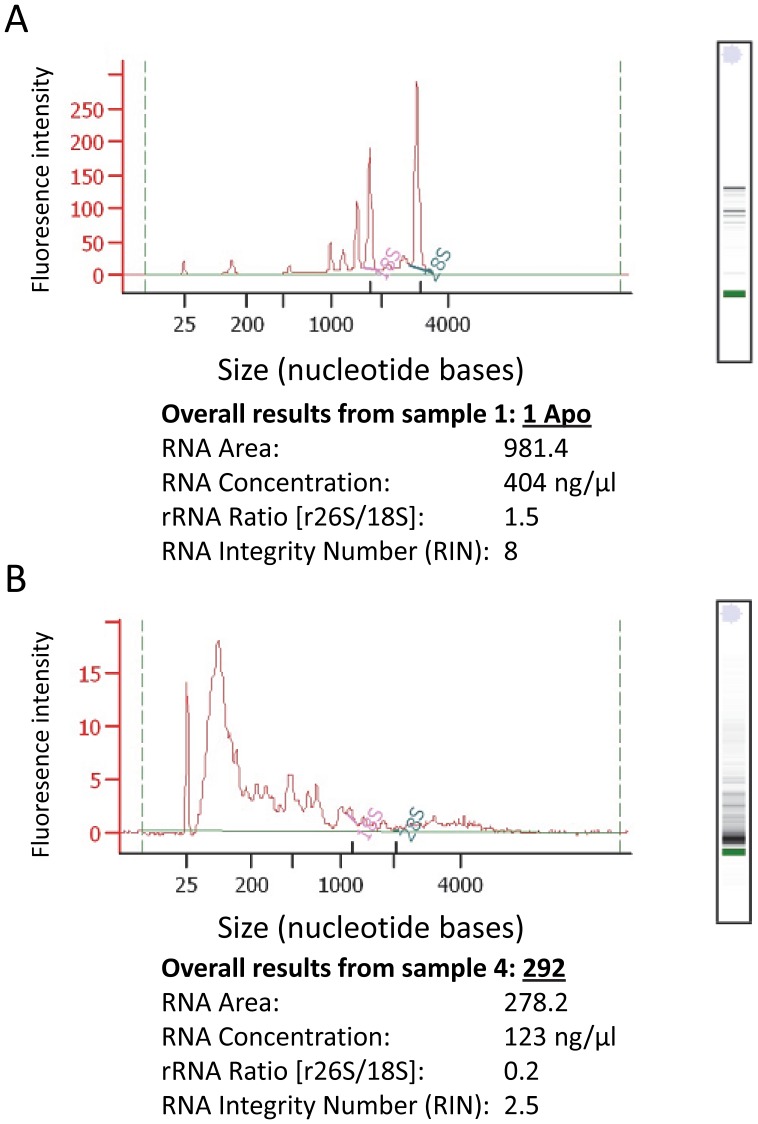
Example of the qualitative and quantitative results from Agilent’s Bioanalyzer 2100.In panels (A) and (B) we show peaks produced from electropherograms (top left) that depict the size distribution of RNA fragments, the corresponding gel-like image of RNA fragments (top right), and metrics of RNA concentration and integrity (r26S/18S and RIN). We show two representative samples with (A) high-quality RNA in terms of high yield and minimal degradation (r26S/18S ≥1, RIN ≥8), and (B) low-quality RNA in terms of modest yield and high degradation (r26S/18S <1, RIN <5). Absence of clear peaks at 26S and 18S and an abundance of short fragments clustering on the left of the electropherogram in panel (B) are the hallmarks of severe RNA degradation. In electropherograms, ribosomal 26S (large) and 18S (small) subunits are shown in green and pink, respectively. Concentrations of 26S and 18S were calculated by taking the area above the green and pink straight lines at the base of the 26S and 18S peaks, respectively.